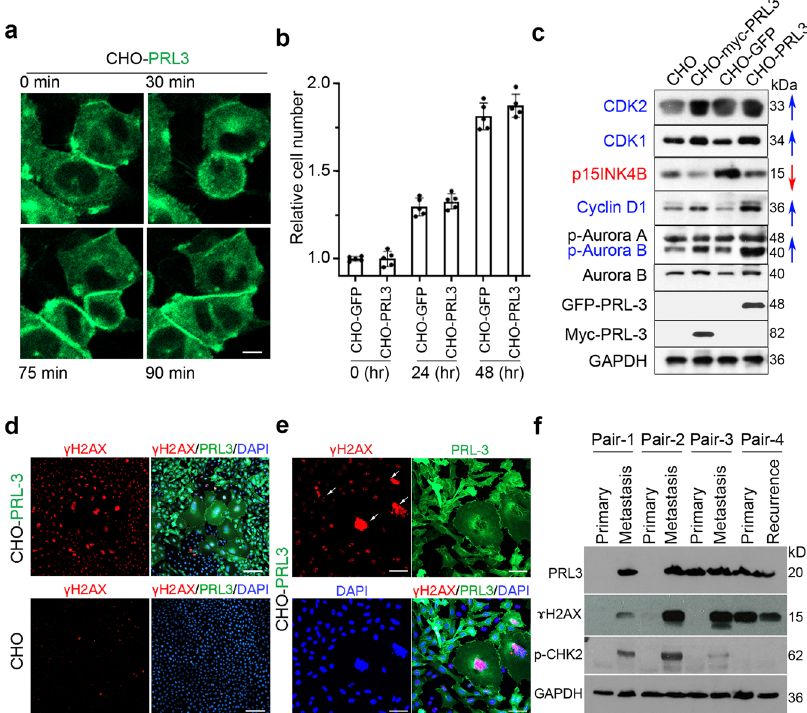
Fig. 2 PRL3 enhances incomplete cytokinesis events despite the accumulation of DNA double-strand breaks. a Representative real-time images of incomplete cytokinesis in CHO-PRL3 cells resulting in multinucleated PGCC formation. Bar, 50 µ m. b No signi fi cant difference between the relative proliferation rate of CHO-GFP versus CHO-PRL3 cells over 48 h as measured using an MTS assay. Results represented as mean ± SD. Data obtained from fi ve biological replicates. P = 0.09, Two-way ANOVA. c Unsynchronized CHO stable cell pools were assayed for various cell cycle-related proteins. Blue arrows indicate PRL3-induced cell cycle activators, whereas red arrows indicate PRL3-suppressed cell cycle inhibitors. GAPDH served as a loading control. d , e DNA double-stranded breaks (DSBs) visualized using immuno fl uorescence of CHO-PRL3 and CHO cells. Bar, 100 µ m ( d ) or CHO-PRL3 cells. Bar, 40 µ m ( e ) with anti-phospho-H2AX ( γ H2AX) antibody. White arrows indicate enlarged nucleus with elevated expression of γ H2AX. Note the extensive accumulation of DSBs in the CHO-PRL3 cell pool compared to CHO cells. f Western blot of four pairs of human primary tumors after chemotherapy and matched distant metastasis or recurrent tumor from the same patient. PRL3 overexpression correlates with intense phosphorylation of ɤ H2AX in all four pairs and with p-Chk2 in three pairs of metastatic